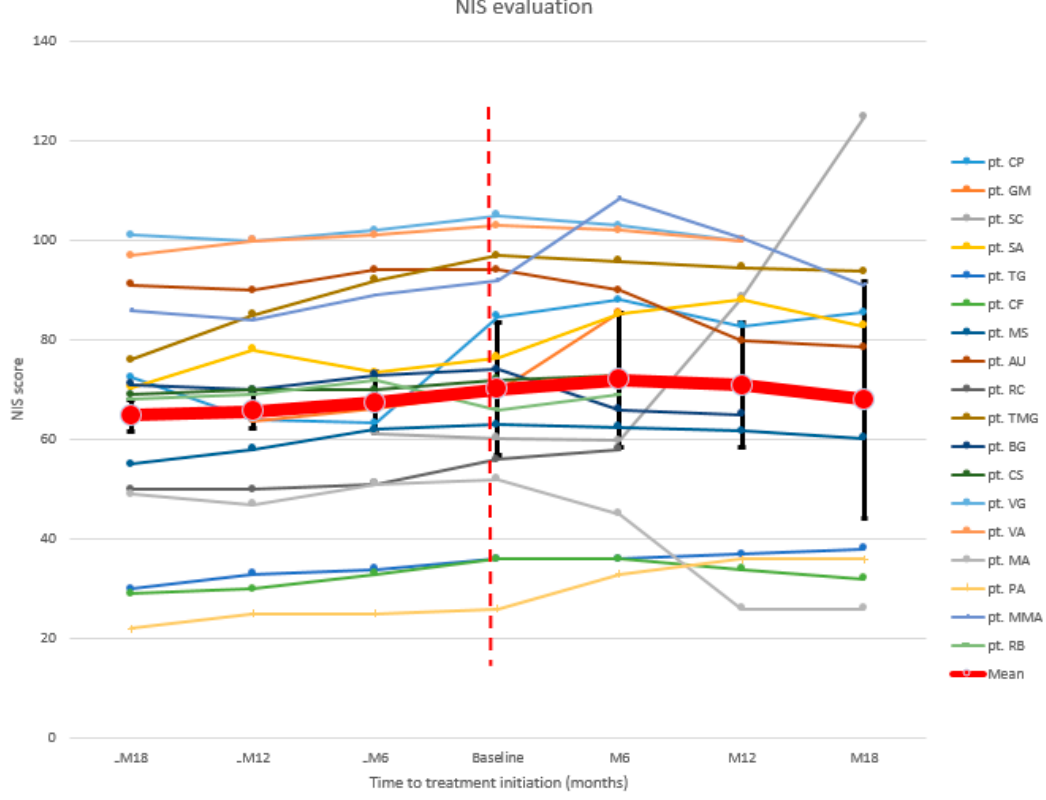
Figure 1. NIS: neuropathy impairment score.